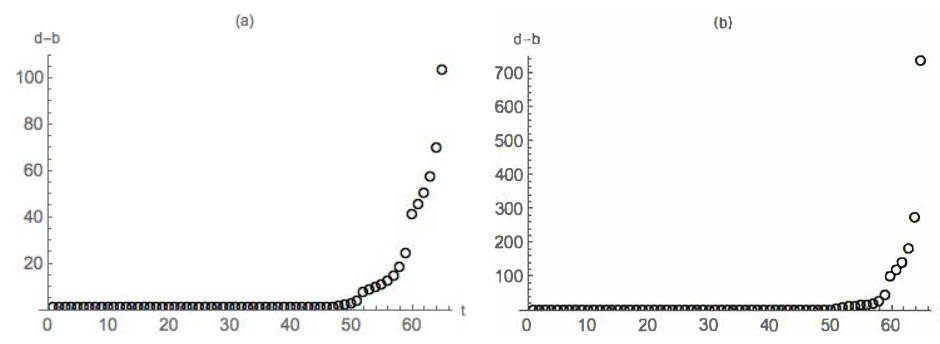
Figure 8. Lifespans d − b for β 0 computed for ( a ) Nx = 50 and ( b ) Nx = 100 triangulations.